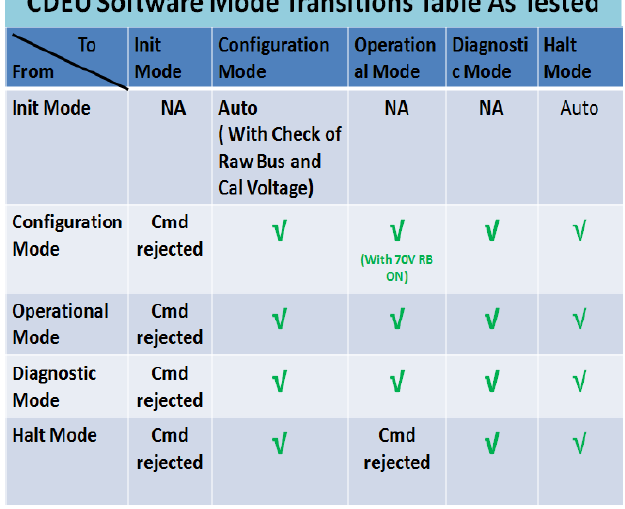
Figure 4. CDEU mode transitions as